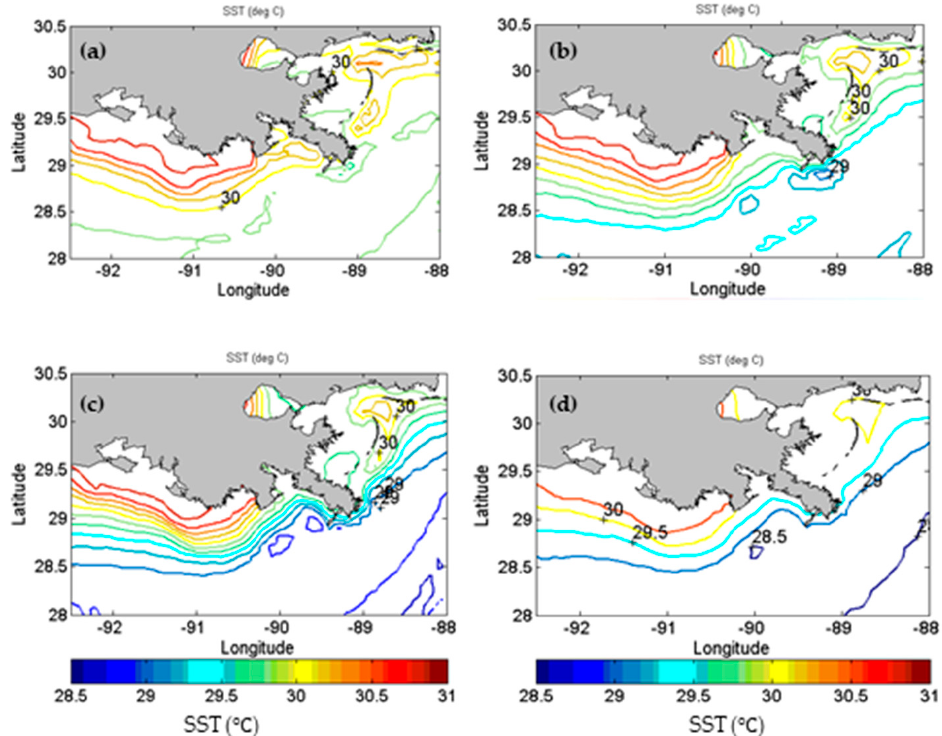
Figure 8. Simulated SST over the Louisiana shelf after different cold front events, ( a ) 10 October 12:00 a.m., ( b ) 17 October 12:00 a.m., ( c ) 22 October 12:00 a.m., ( d ) 27 October 12:00 a.m.